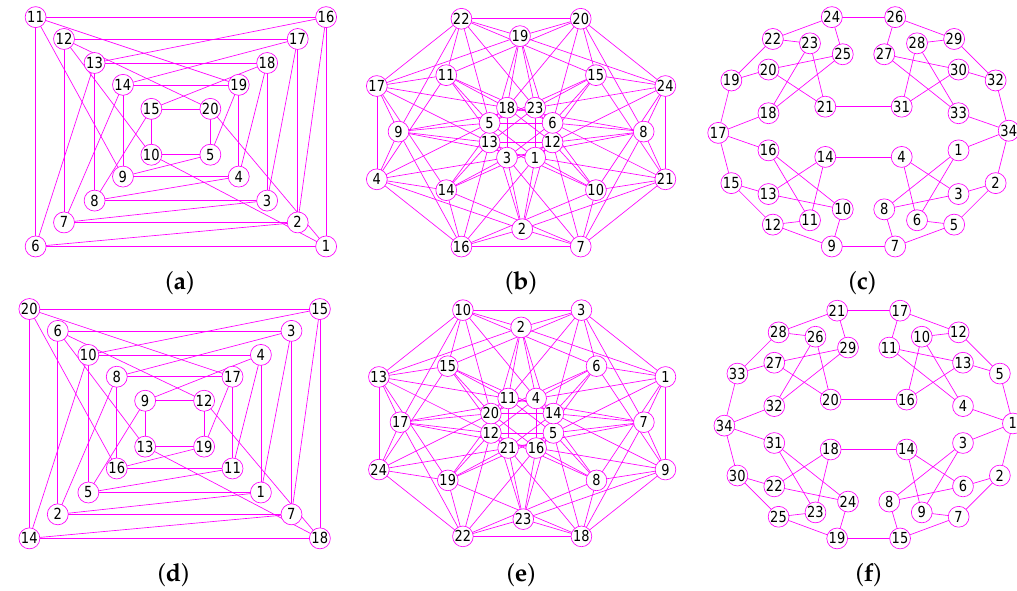
Figure 22. The TopMost graphs of three graphs G 37 , G 38 and G 39 . ( a ) The Folkman graph G 37 of 20 vertices and 40 edges; ( b ) The 24-cell graph G 38 with 24 nodes and 96 edges; ( c ) The Thomassen graph G 39 of 34 nodes and 52 edges; ( d ) The TopMost graph of G 37 ; ( e ) The TopMost graph of G 38 ; ( f ) The TopMost graph of G 39